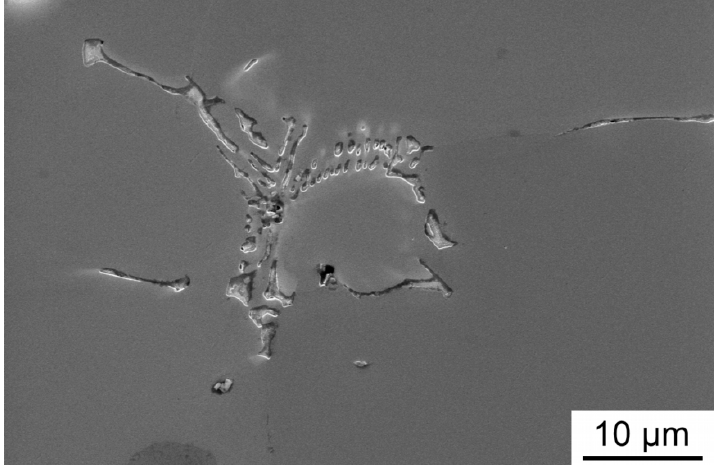
Figure 4. Intermetallic α -AlFeMnSi phase in the cast non-homogenized rod.